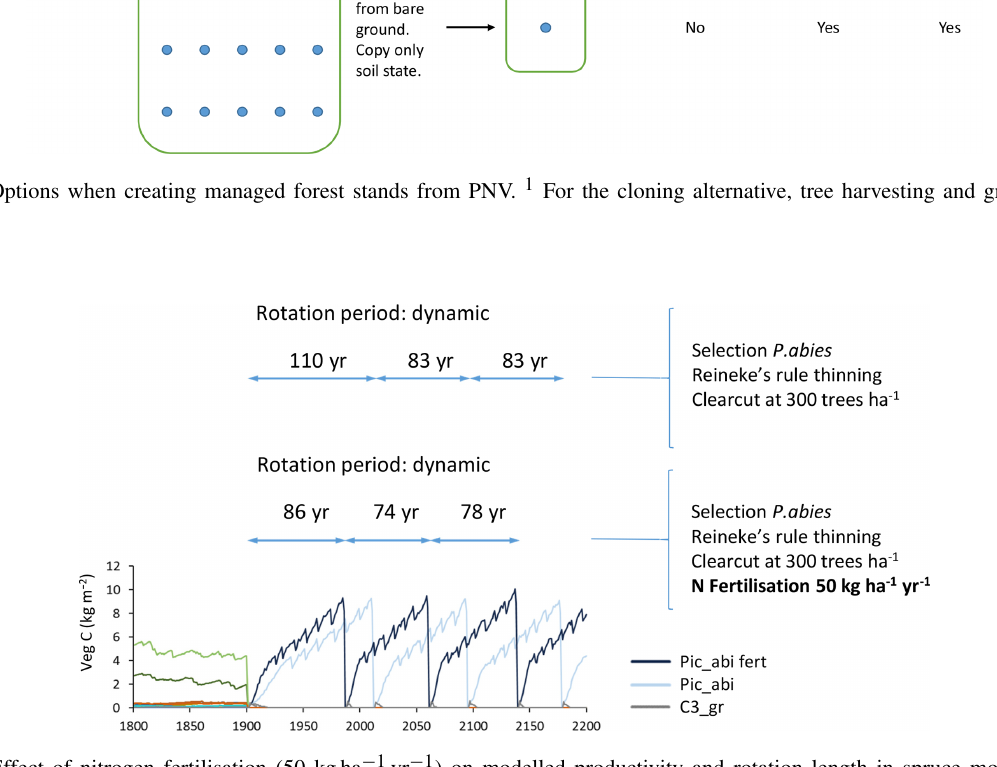
Figure B2. Effect of nitrogen fertilisation (50 kgha − 1 yr − 1 ) on modelled productivity and rotation length in spruce monoculture with automated thinning and clear-cutting. Abbreviations are as follows: Pic_abi fert, Picea abies with N fertilisation; Pic_abi, Picea abies without N fertilisation; C3_gr, C 3 grass. Forestry stands were created from clear-cutting of PNV in 1901. Location, climate input, and species in PNV are as in Fig.